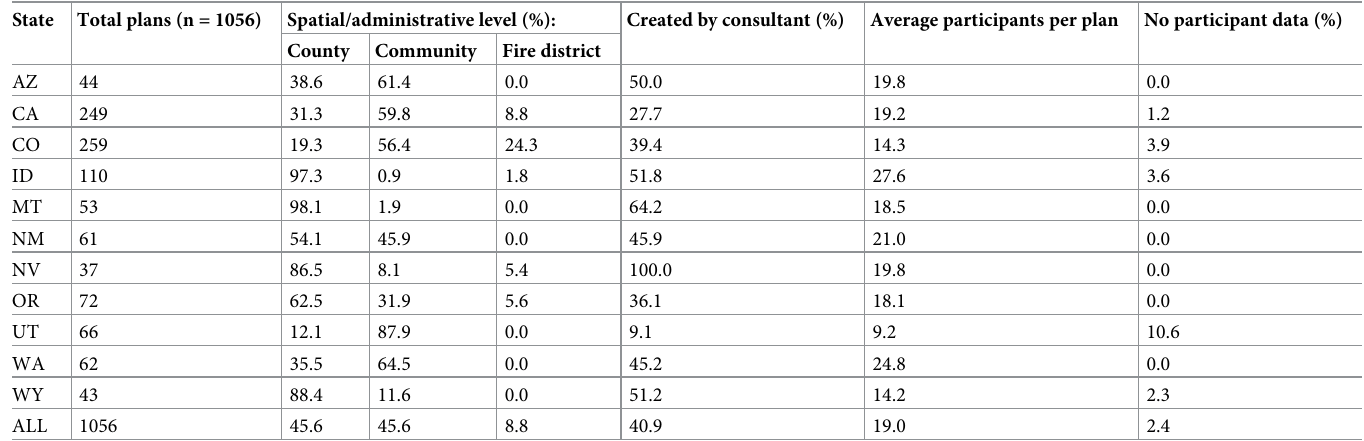
Table 1. Characteristics of plans.